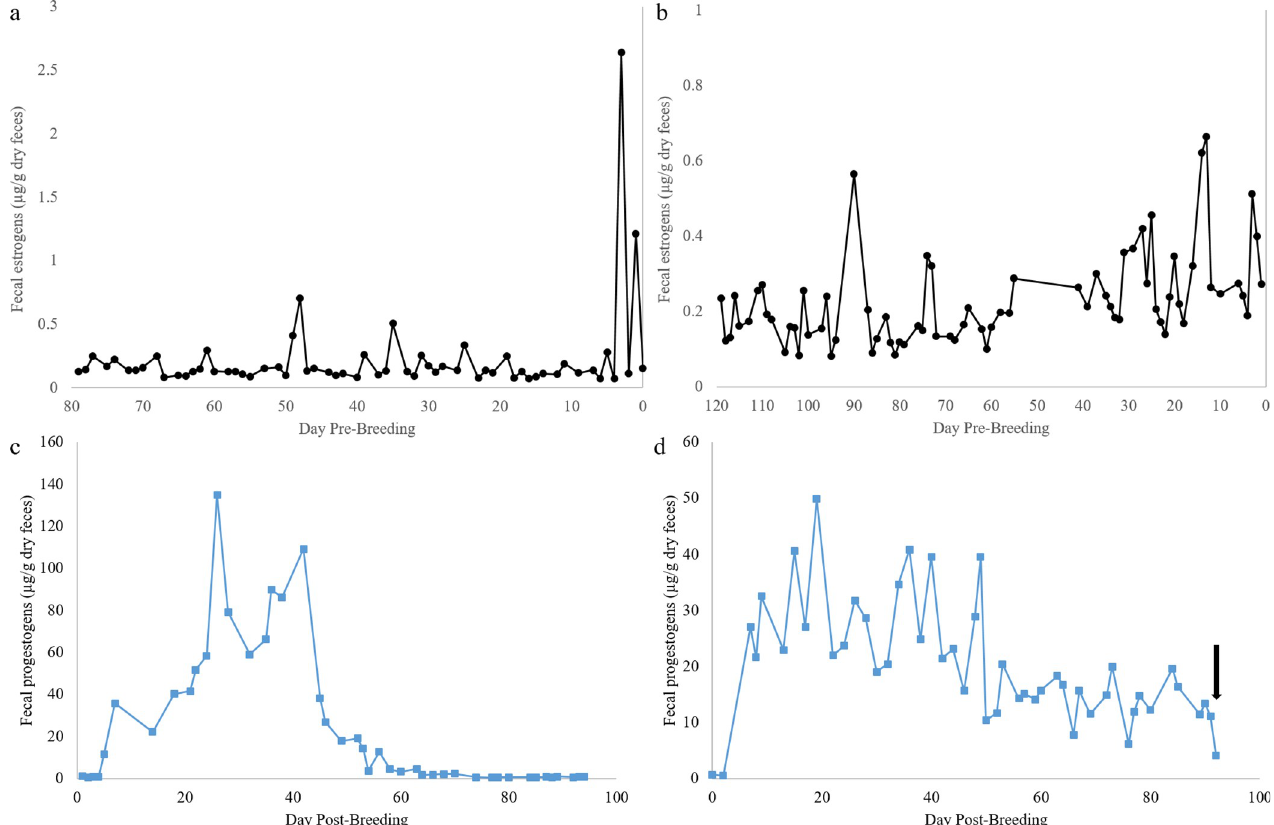
Fig 1. Cheetah estrogen and progestogen fecal metabolite profiles. (a) Estrogen fecal metabolite profile of a cycling female prior to natural breeding and successful pregnancy. (b) Estrogen fecal metabolite profile of a cycling female prior to natural breeding and non-pregnant luteal phase (Axes are different scales). (c) Progestogen fecal metabolite profile of a non-pregnant luteal phase after natural breeding. Progestogen metabolite concentrations return to pre- ovulatory levels around ~55 days post-breeding. (d) Progestogen fecal metabolite profile of a pregnant female after natural breeding. Progestogen fecal metabolite concentrations remain elevated until parturition (Parturition indicated by arrow) (Axes are different scales).